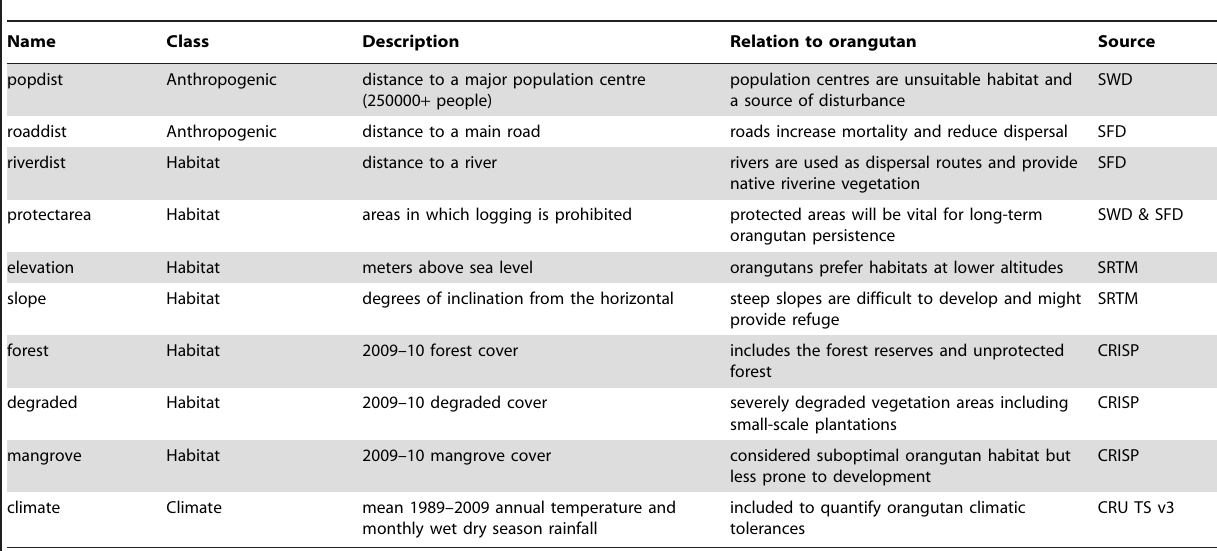
Table 1. Spatial predictors used to build the Species Distribution Model with notes on their perceived importance for orangutan and data